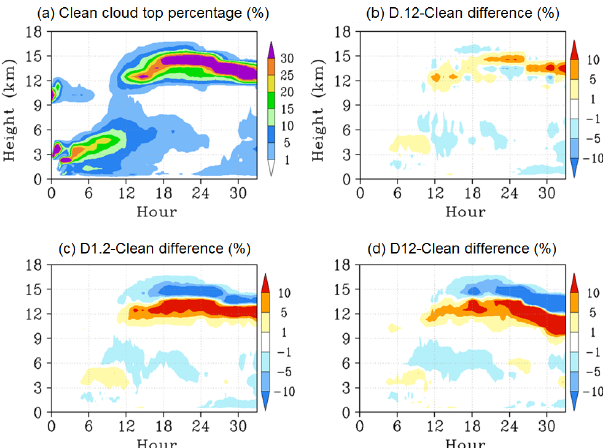
Figure 4. Time series of percentage of cloud tops occurring at each altitude for the (a) Clean case and the associated dust case minus Clean case difference plots for the (b) D.12–Clean, (c) D1.2–Clean, and (d) D12–Clean